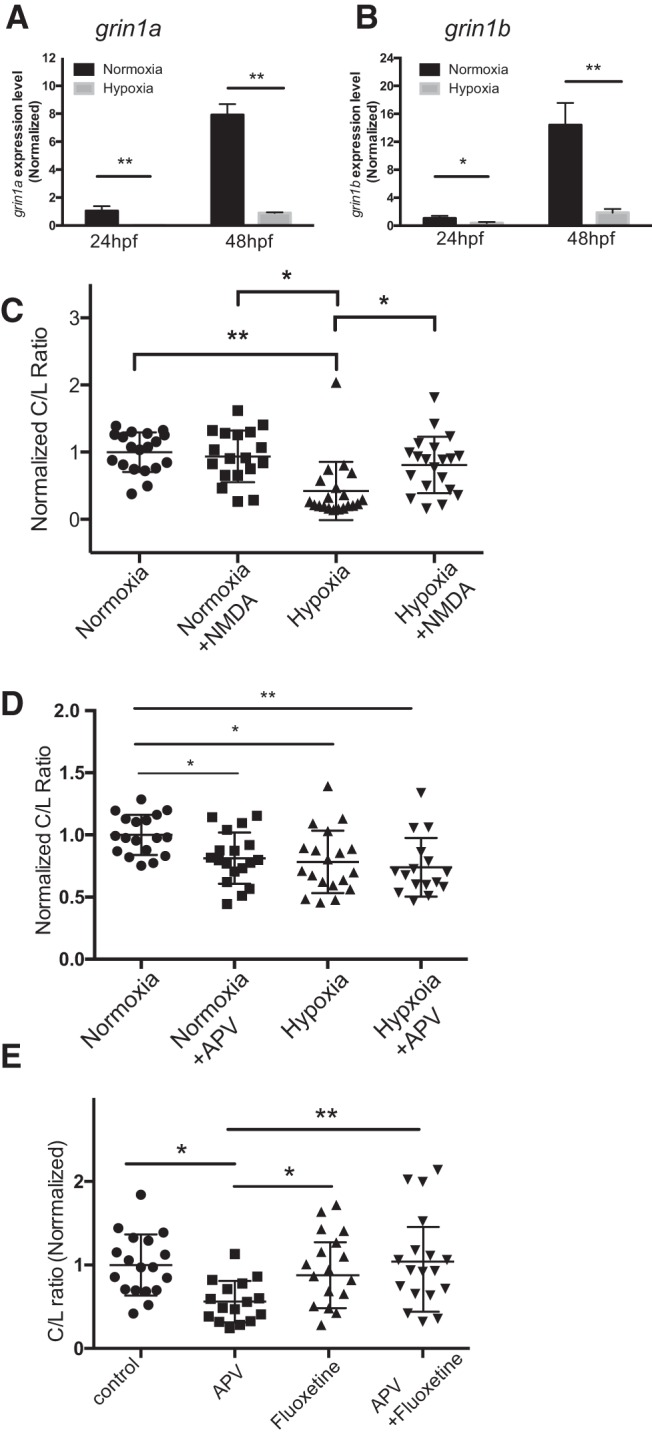
The NMDAR interacts with other known mechanisms to control midline crossing. A, B, Hypoxia causes reductions of grin1a and grin1b subunit expression at 24 and 48 hpf, during TCPT midline crossing. qRT-PCR, triplicate experiments, normalized to elf1a. Error bars, SEM; *p < 0.05; **p < 0.01. C–E, Scatterplot C/L results for TCPT crossing, ns, not significant; *p < 0.05; **p < 0.01; ANOVA with post hoc Tukey’s HSD. C, Hypoxic reduction of midline crossing is rescued by addition of NMDA. D, Blockade of NMDAR does not worsen hypoxia impairment of midline crossing. E, Increased serotonin signaling rescues midline crossing defect from NMDAR blockade.